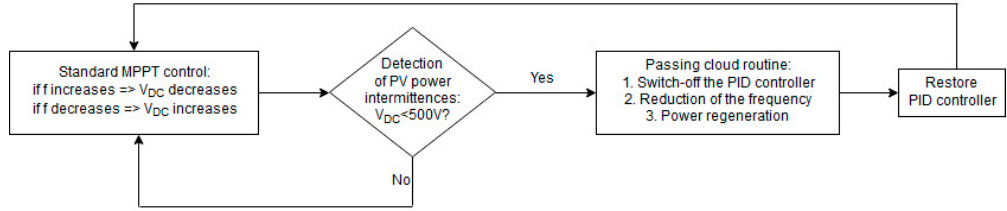
Figure 7. The “passing-cloud” control strategy ( f is the frequency and V DC the DC bus voltage).